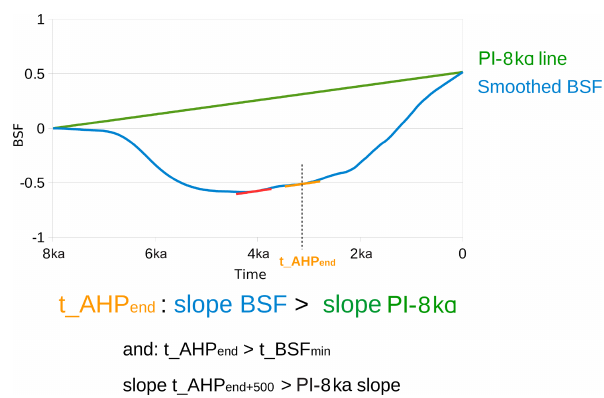
Figure 1. Sketch of the definition of the AHP end in the model. We calculate the AHP end based on the strongly smoothed (loess filter, span = 70) bare soil fraction (BSF) change. The time step T end at which the slope between two consecutive time steps exceeds the slope of a straight line between the PI and the 8ka bare soil fraction is regarded as the end of the AHP. Additionally, the minimum of the bare soil fraction has to precede T end and after 500 years, the slope has still to be larger than the slope of the straight